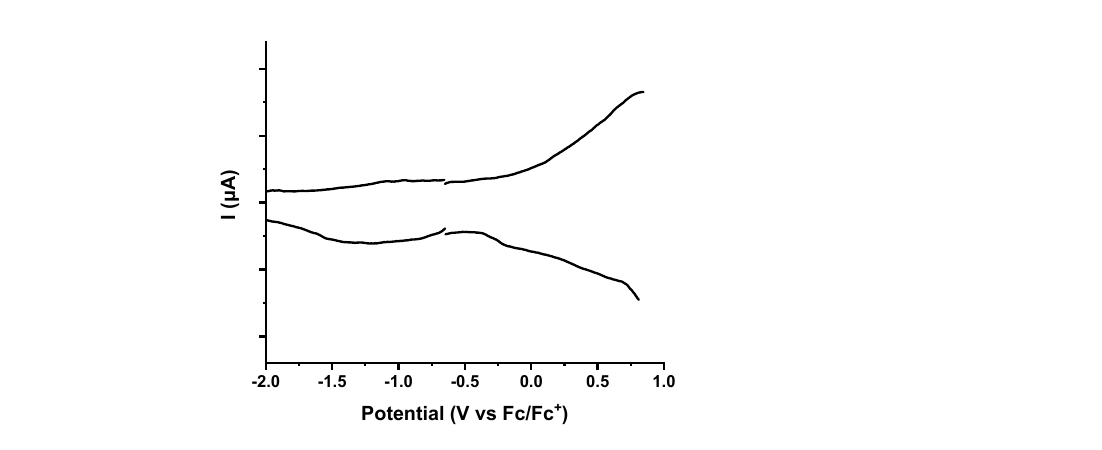
Figure A1. ( a ) Representative (average) Raman spectra (514 nm) of exfoliated graphene (black), pyr- graphene (purple) and imi-graphene (light blue). Spatial Raman spectra (514 nm, 30 × 30 µm area) of ( b ) exfoliated graphene, ( c ) pyr-graphene and ( d ) imi-graphene, depicting the D/G intensity ratio.